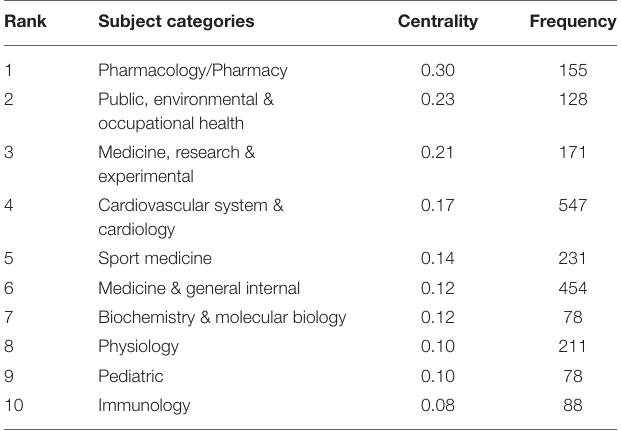
TABLE 1 | Top 10 subject categories based on centrality related to exercise-based renal rehabilitation.